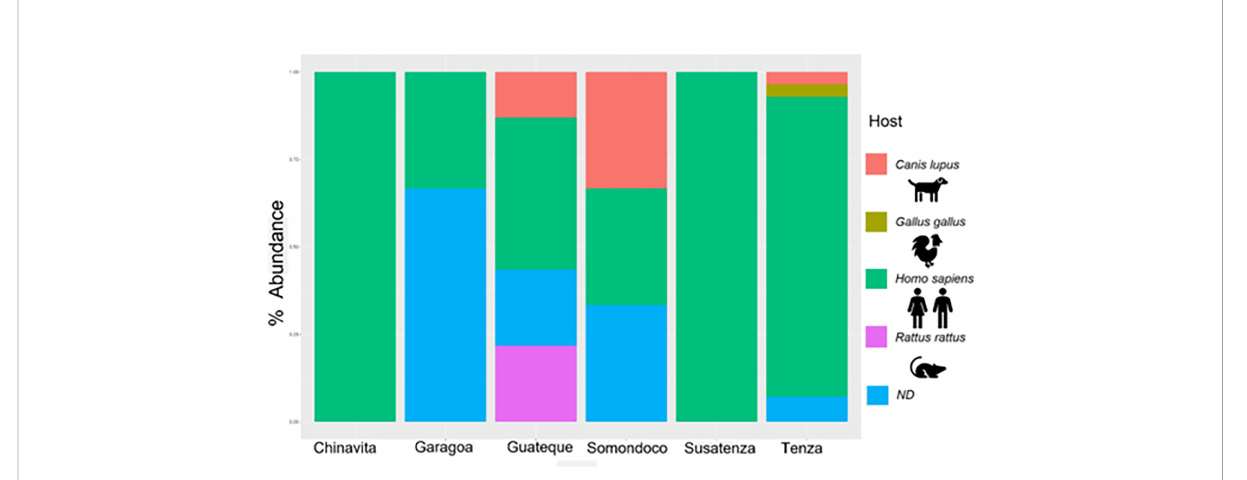
FIGURE 2 Summary of feeding pro fi les of T. venosa specimens per municipality. The barplot shows top 4 blood meals T. venosa fed